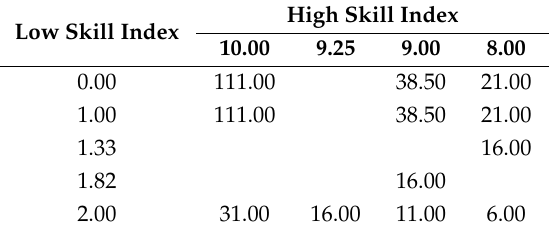
Figure 5. Cumulative resource utilization. Table 2. 16:1 Estimate Ratios by Skill